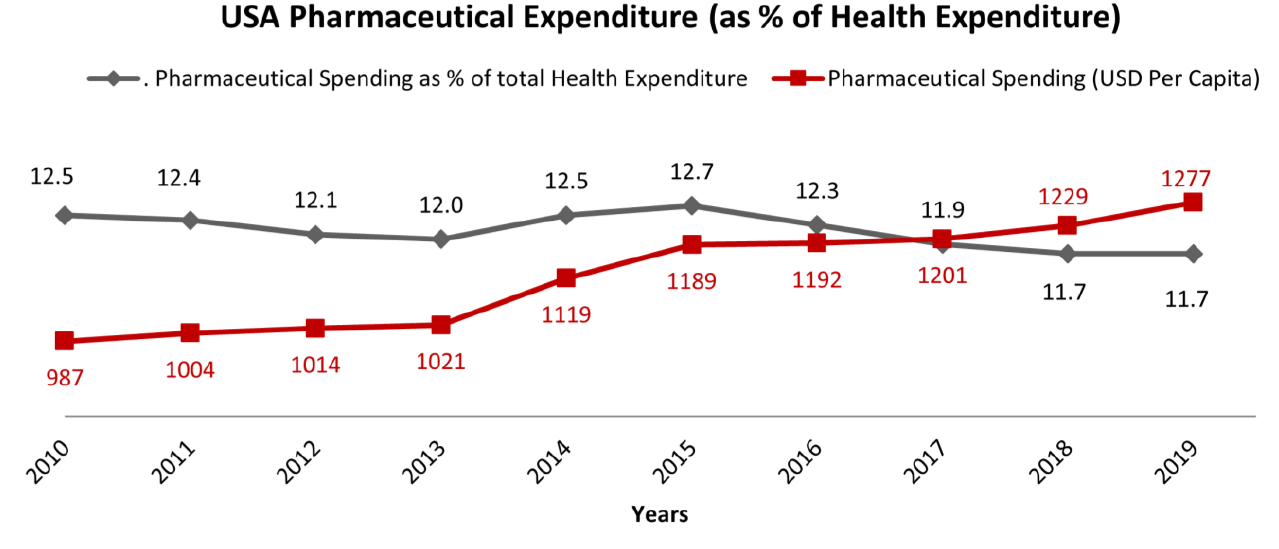
Figure 3. Pharmaceutical Spending as % of total Health Expenditure (pharmaceuticals in hospitals are not considered) and Pharmaceutical Spending as % of total Health Expenditure in the period of 2010–2019 [2].